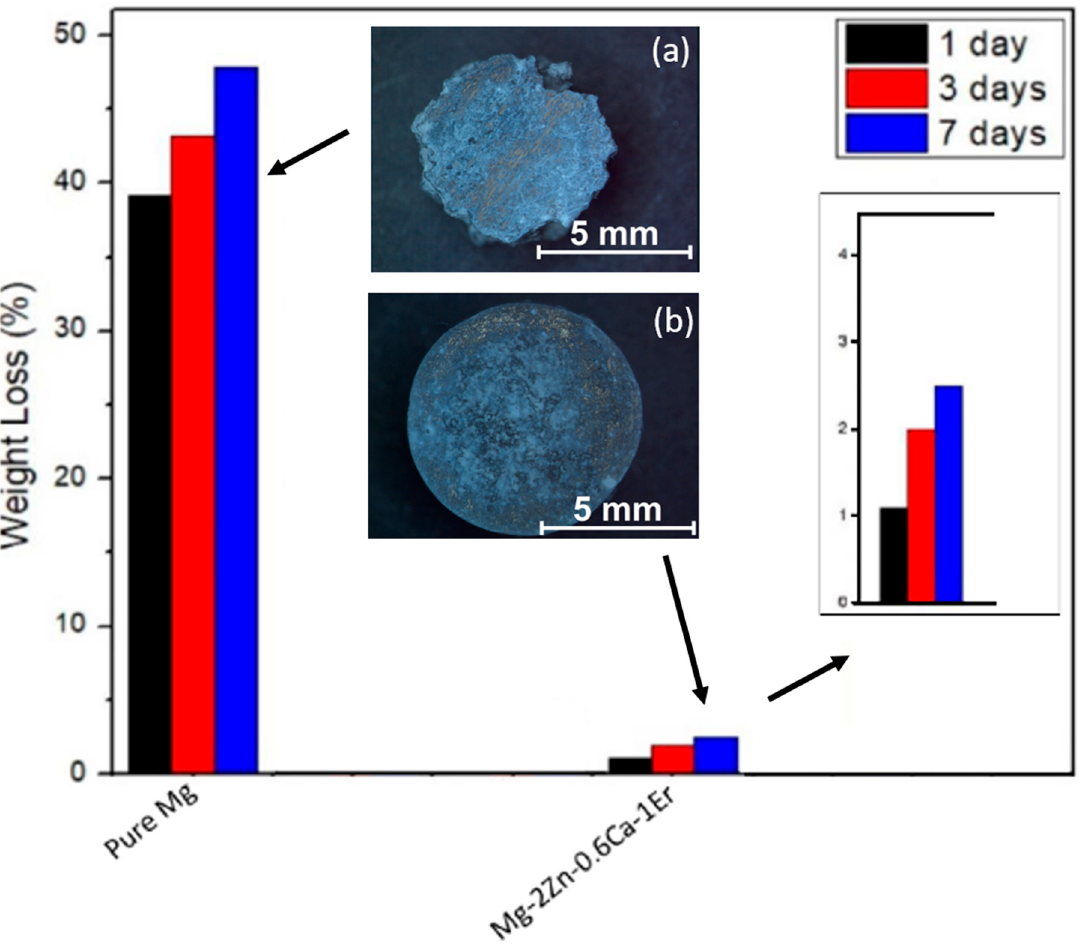
Figure 9. Immersion test results of pure Mg and Mg-2Zn-0.6Ca-1Er in 0.5 wt.% NaCl solution at 37 °C for 1, 3, and 7 days. The graph in the inset is the magnified version of weight loss measurements of Mg-2Zn-0.6Ca-1Er and the macrostructures of ( a ) pure Mg ( b ) Mg-2Zn-0.6Ca-1Er after immersion for 7 days in 0.5 wt.% NaCl solution .